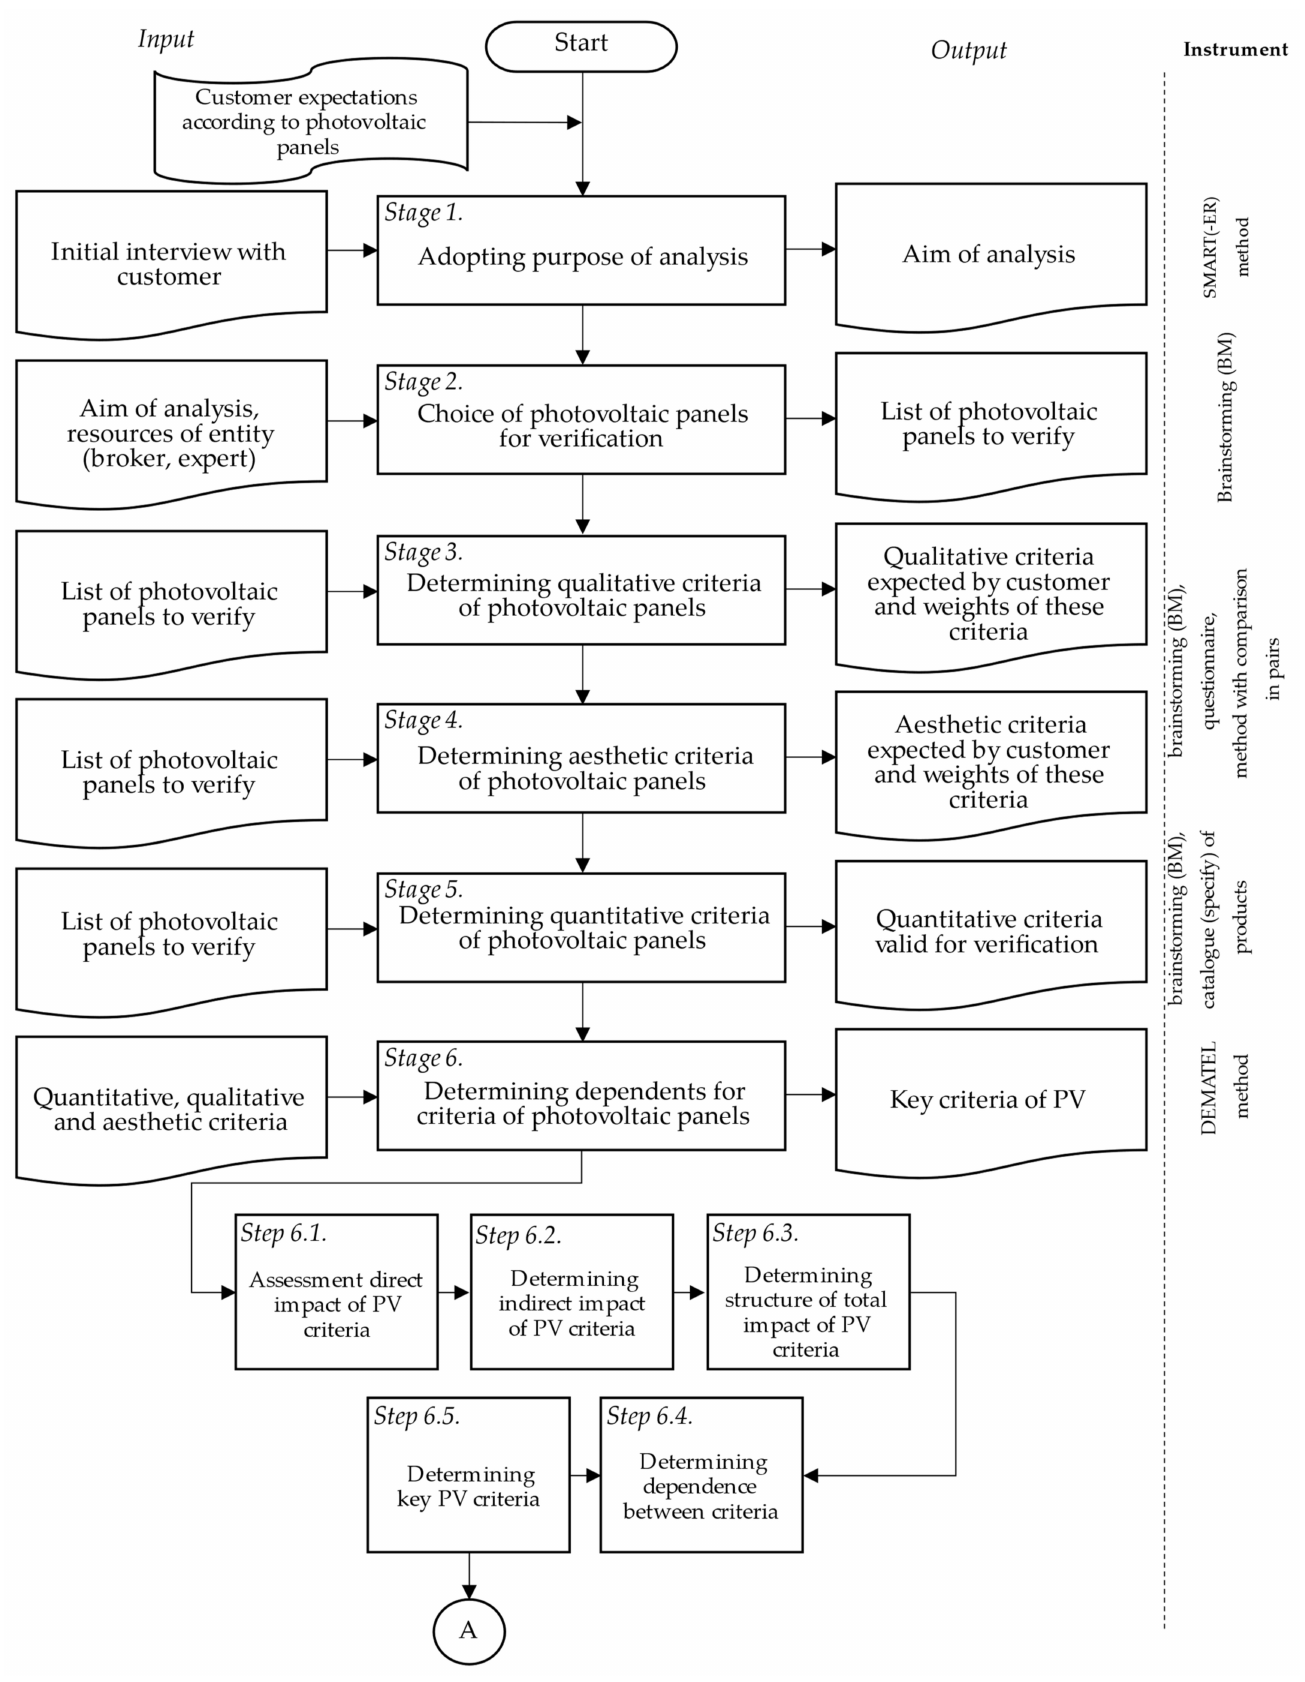
Figure 3. Model of prediction of quality photovoltaic panels—part 1. Own